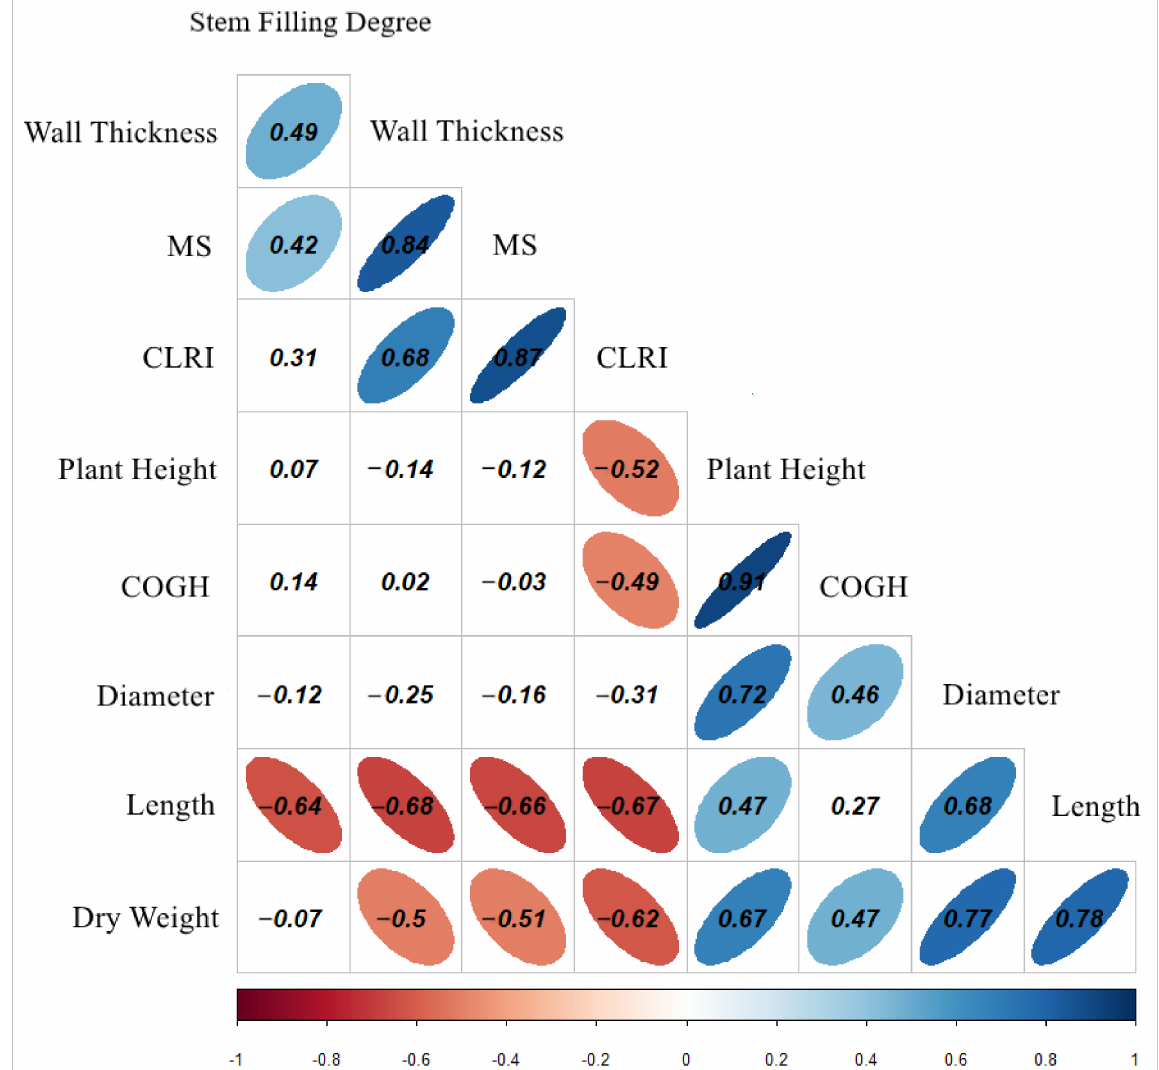
Figure 6. Correlation analysis of morphological characteristics. COGH: the center of gravity height; MS: mechanical strength; CLRI: culm lodging resistance index; ellipse indicates significant difference at 0.01